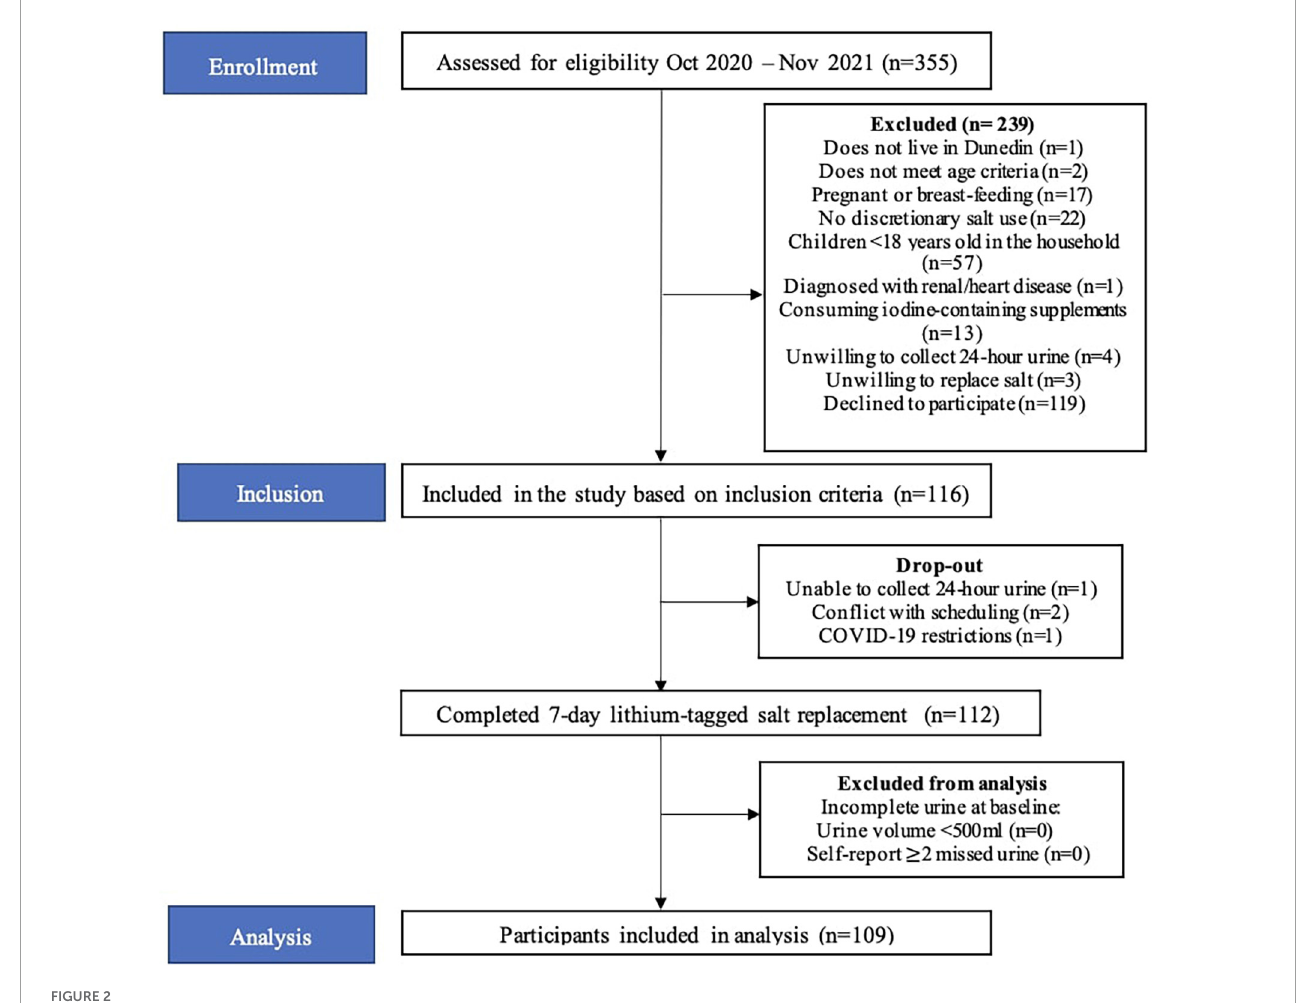
FIGURE2 Participant